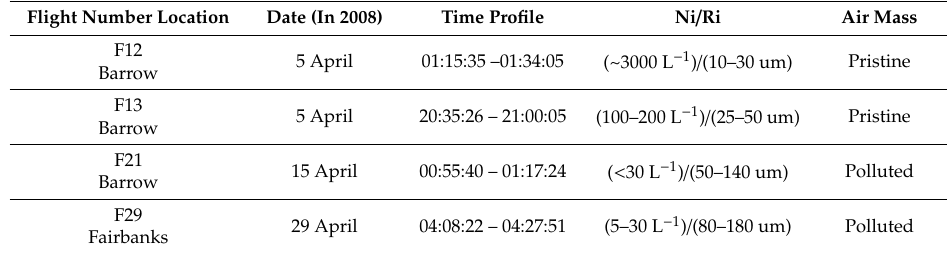
Table 3. Flight number, location, dates, time, Ni, Ri and type of air mass of the ice clouds investigated in this